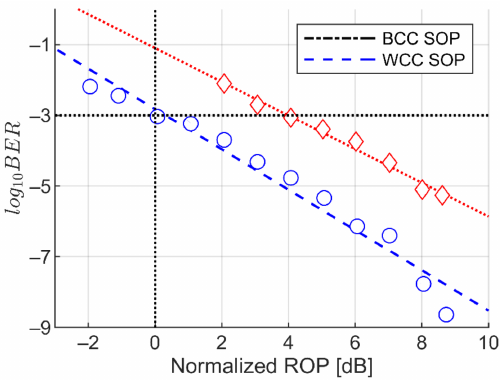
Figure 9. BER curve for best case scenario and worst-case scenario of state of polarization.